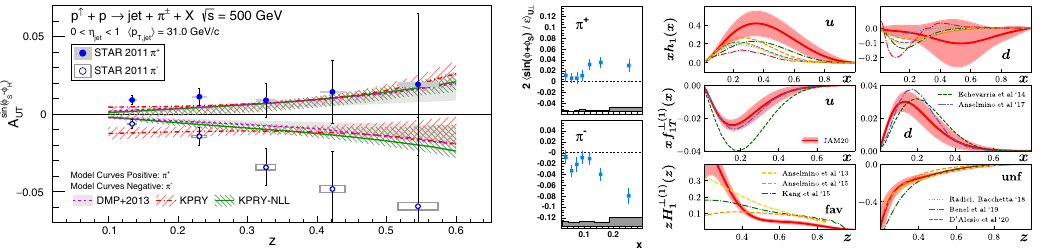
FIG.2. Theextractedfunctions h 1 ð x Þ , f ⊥ ð 1 Þ 1 T ð x Þ ,and H ⊥ ð 1 Þ 1 ð z Þ at FIG. 14. Collins asymmetries as a function of pion z for jets reconstructed with 22 . 7 < p T < 55 . 0 GeV =c and 0 < η < 1 . The Figure 8 . Collins SFA for charged mesons (left: pions; right: kaons) presented either in bins of x , Q 2 ¼ 4 GeV 2 from our (JAM20) global analysis (red solid asymmetries are shown in comparison with model calculations from Refs. [74,78]. The calculations are based upon SIDIS and e þ e − z , or P h . Data at large values of z , marked by open points in the z projection, are not included curves with 1 - σ CL error bands). The functions from other results and assume robust factorization and universality of the Collins function. The DMP þ 2013 [74] and KPRY [78] predictions ⊥ Figure 5: Left: STAR Collins asymmetries from charged pions in jets in p ↑ p [ 37 ] . in the other projections. Systematic uncertainties are given as bands, not including the additional groups [82,95,102,103,106,115,119,120] are also shown. assume no TMD evolution, while the KPRY-NLL [78] curves assume TMD evolution up to next-to-leading log. All predictions are scale uncertainty of 7.3% due to the precision of the target-polarization determination. shownwithshadedbandscorrespondingtothesizeoftheirassociatedtheoreticaluncertainties.Thegeneralagreementbetweenthedata Middle: HERMES Collins asymmetries for charged pions in SIDIS [ 15 ] . Right: JAM and the model calculations is consistent with assumptions of robust TMD factorization and universality of the Collins function. global fits for transversity TMD (top), Sivers TMD (middle), Collins FF (bottom) [ 28 ]